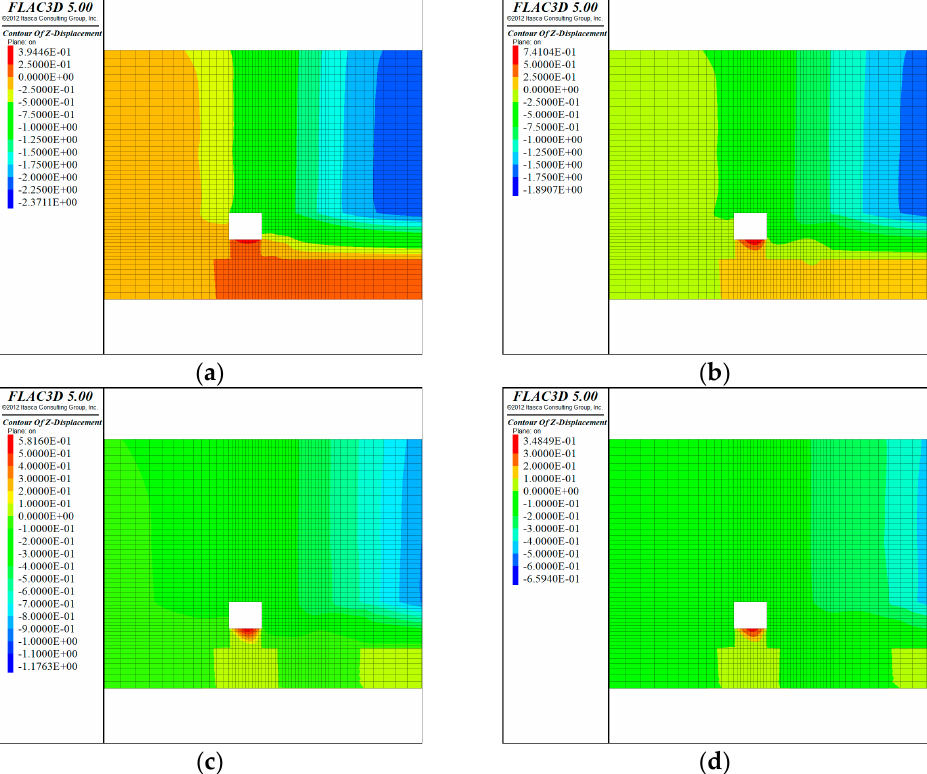
Figure 4. Vertical displacement of coal pillars with different widths. ( a ) Coal pillar of 4 m wide; ( b ) coal pillar of 10 m wide; ( c ) coal pillar of 15 m wide; ( d ) coal pillar of 20 m wide.